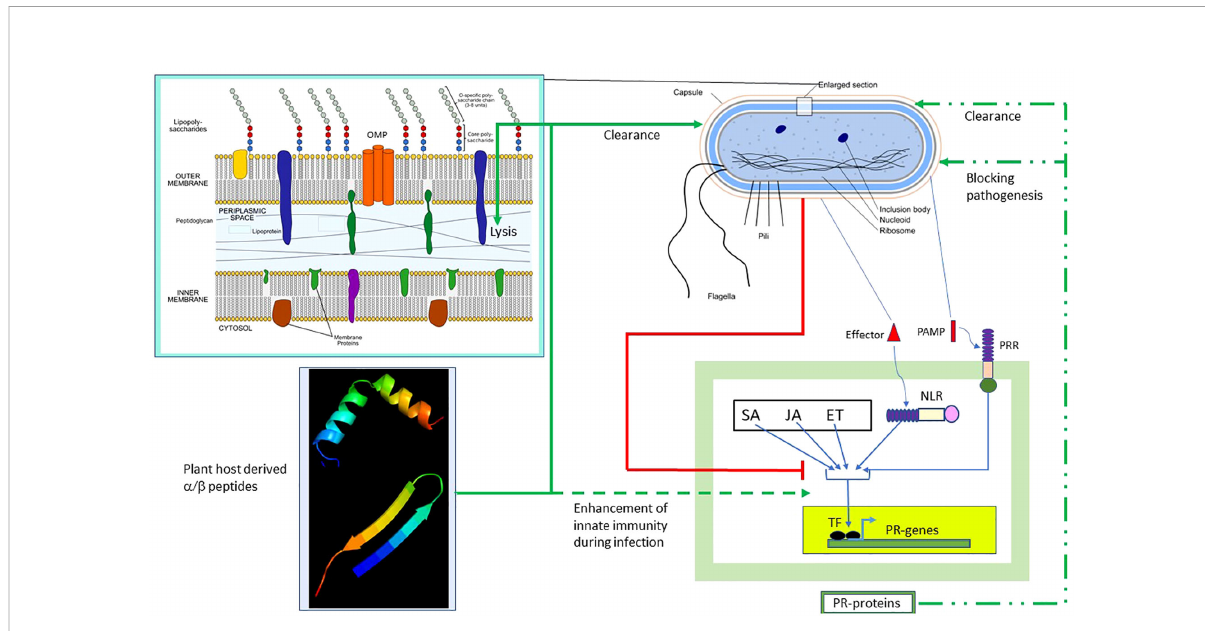
FIGURE 8 Effect of a / b peptides on plant – bacteria interaction. The schematic representation of the Gram-negative bacterium was adapted from https:// en.wikipedia.org/wiki/Gram-negative_bacteria. Several intracellular and membrane-bound bacterial components are shown. The (OM – periplasm – IM) section was enlarged. Bacterial PAMP induces PTI, whereas the effector activates ETI. The SA/JA/ET pathways act in concert with the PT/ETI pathways to induce the TF, leading to the production of pathogenesis-related (PR) proteins capable of clearing bacteria and/or blocking pathogenesis ( broken green lines ). Bacteria employ multiple strategies to block the PTI/ETI/SA/JA/ET pathways ( solid red lines ). The a / b peptides overcome bacterial resistance. They clear bacteria by membrane lysis ( solid green lines ) and also augment the PTI/ETI/SA/JA/ET response during infection ( dashed green lines ). TF , transcription factor; ET , ethanol; ETI , effector-triggered immunity; IM , inner membrane; JA , jasmonic acid; NLR , Nod-like receptor; PAMP , pathogen-associated membrane pattern; PRR , plasma membrane recognition receptor; PTI , PAMP-triggered immunity; SA , salicylic